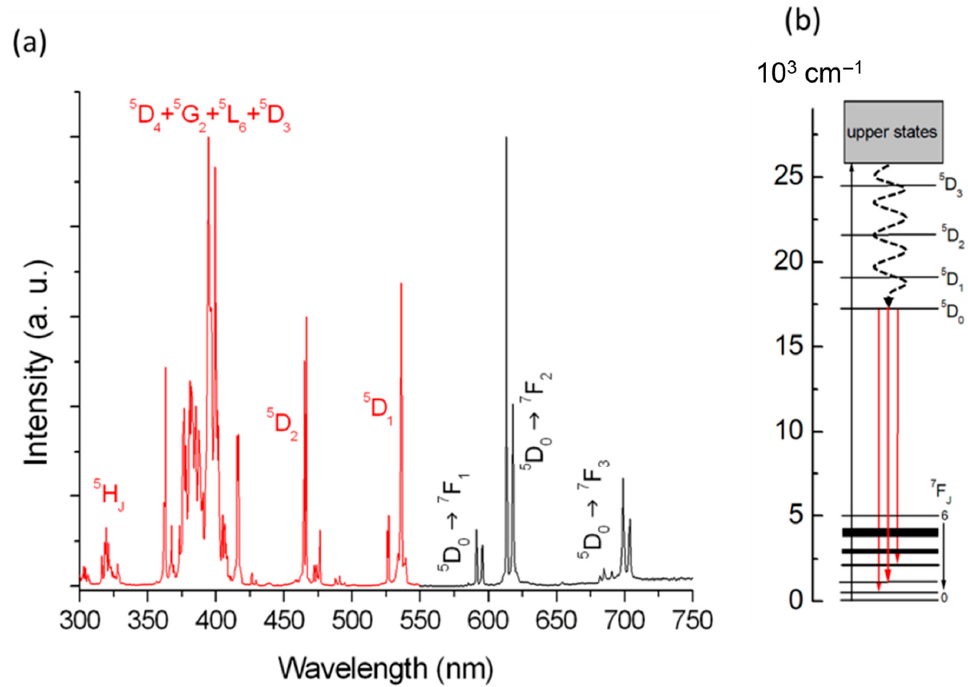
Figure 3. ( a ) Excitation (monitored wavelength: 613 nm) and emission (excitation at 394 nm) spectrum of EuAB. ( b ) Energy levels scheme and de-excitation mechanisms.